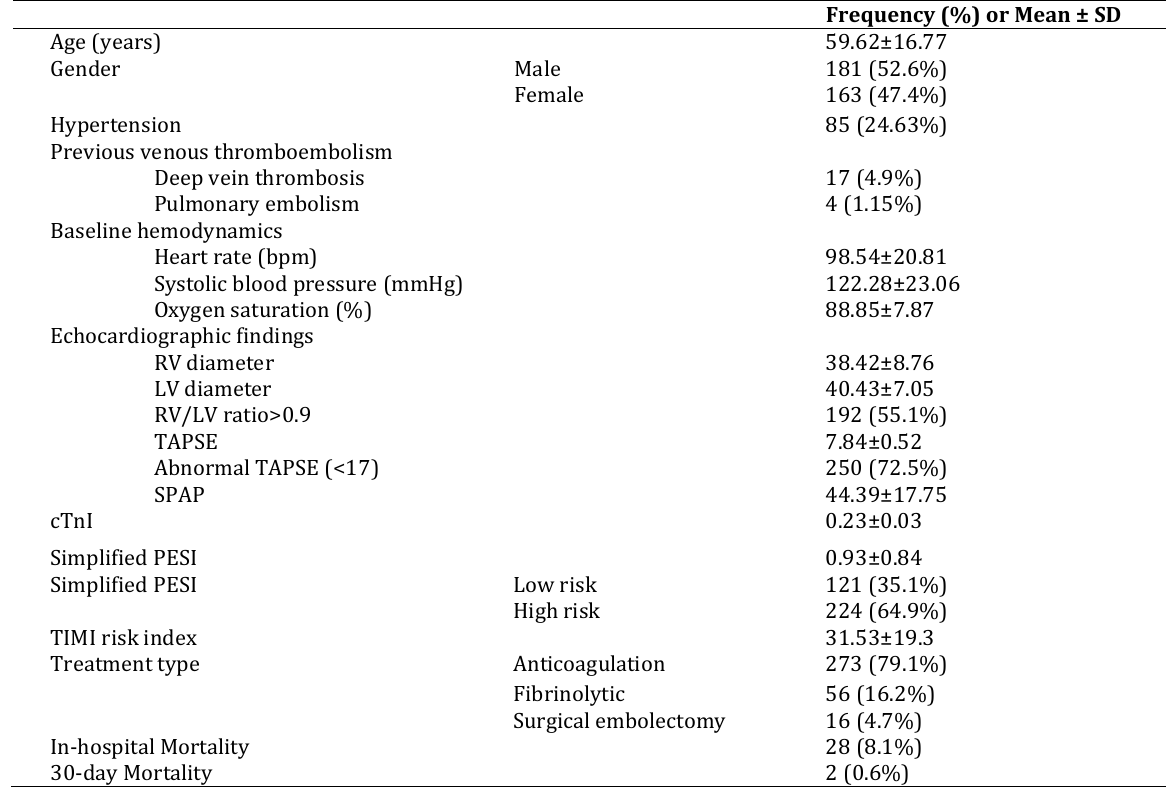
Table 1: The baseline, echocardiographic and follow-up findings of PTE patients